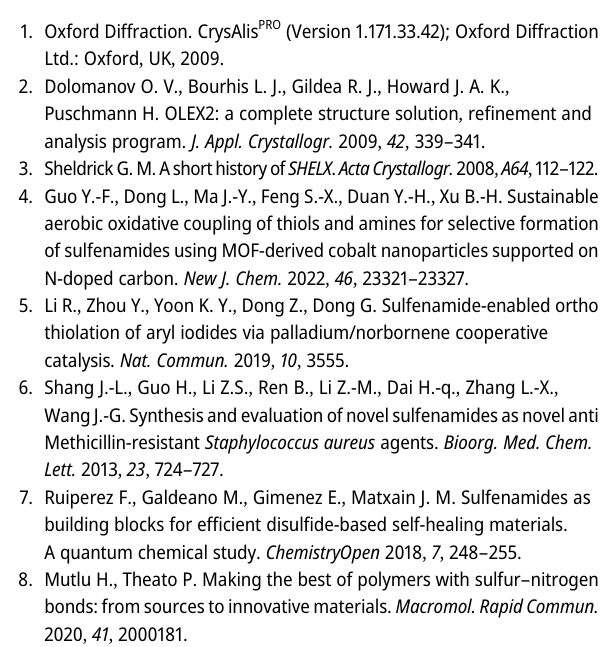
indicates that the S – N bond constructs in the compound. The 2-mercaptobenzothiazole together with nitrogen atom is almost strictly planar, whereby the largest deviation for the N2 atom from the 2-mercaptobenzothiazole plane is 0.149 Å. The dihedral angle between the N2 – S2 – C7 plane and C9 – N2 – S2 plane of the major components of S -(benzo[ d ]thiazol-2-yl)- N -( tert -butyl) thiohydroxylamine were found to be 68.26 ° . The